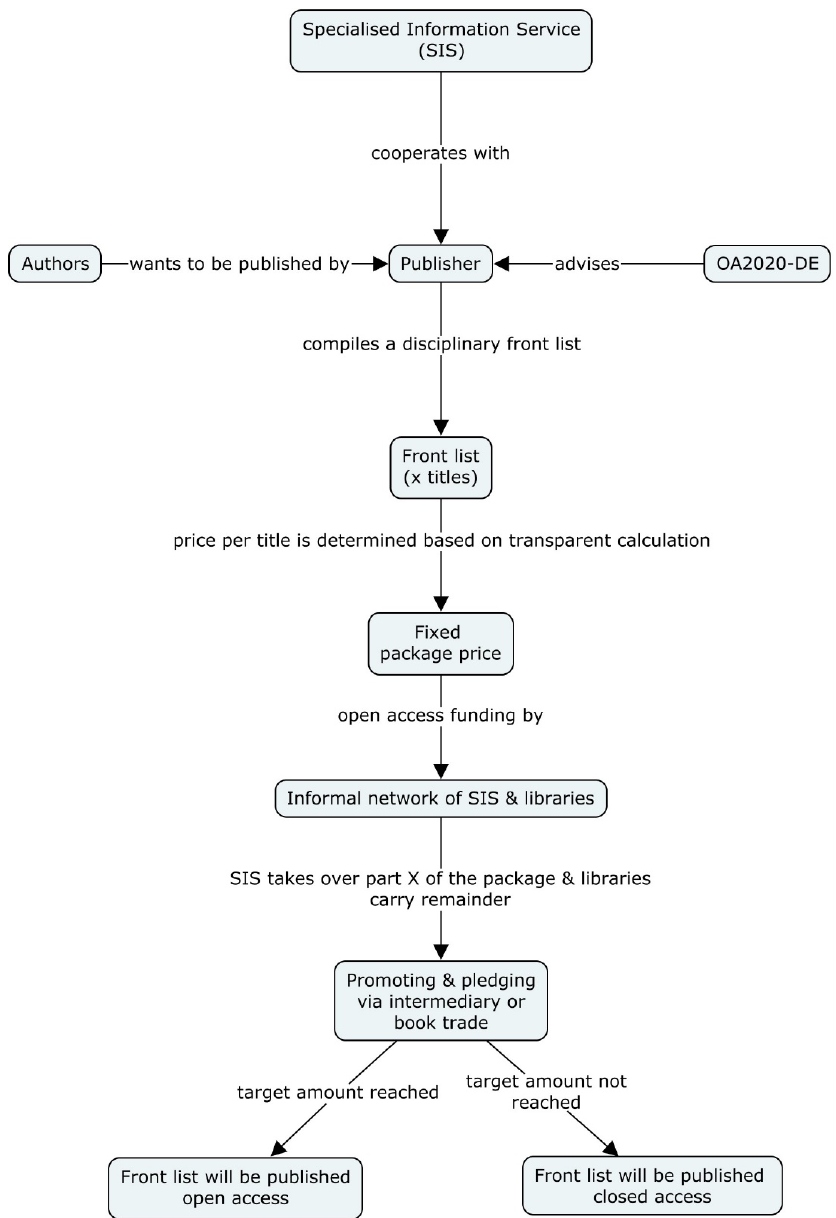
Figure 1. Workflows and relationships in the transcript OPEN Library Political Science model.